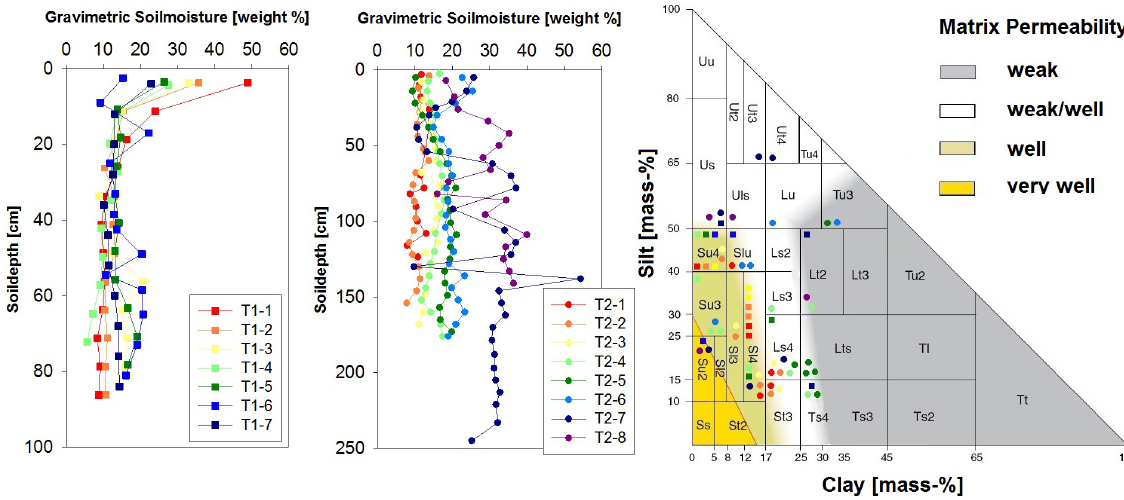
Fig. 2. Gravimetric soil moisture and soil texture with matrix permeability after Scherrer (2006) of soil samples from every vertical depth profile for both study hillslope transects.